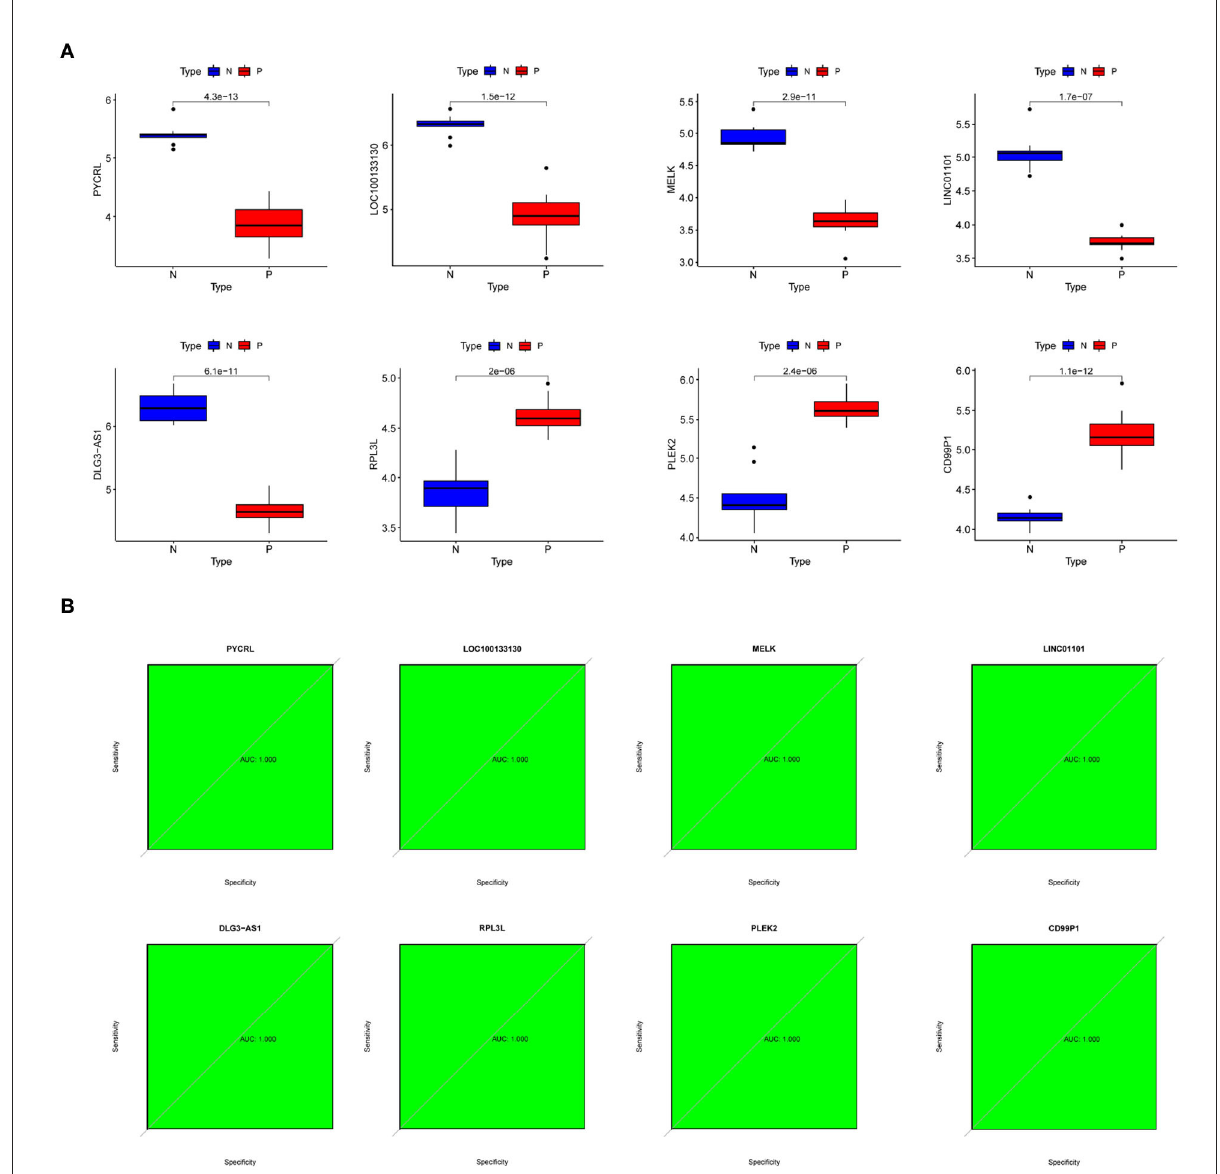
FIGURE6 The expression levels and diagnostic implications of the hub genes. (A) The expression levels of hub genes in PD patients and normal samples of the dataset (number: GSE7621); (B) ROC curves of hub genes of the dataset (number: GSE7621).